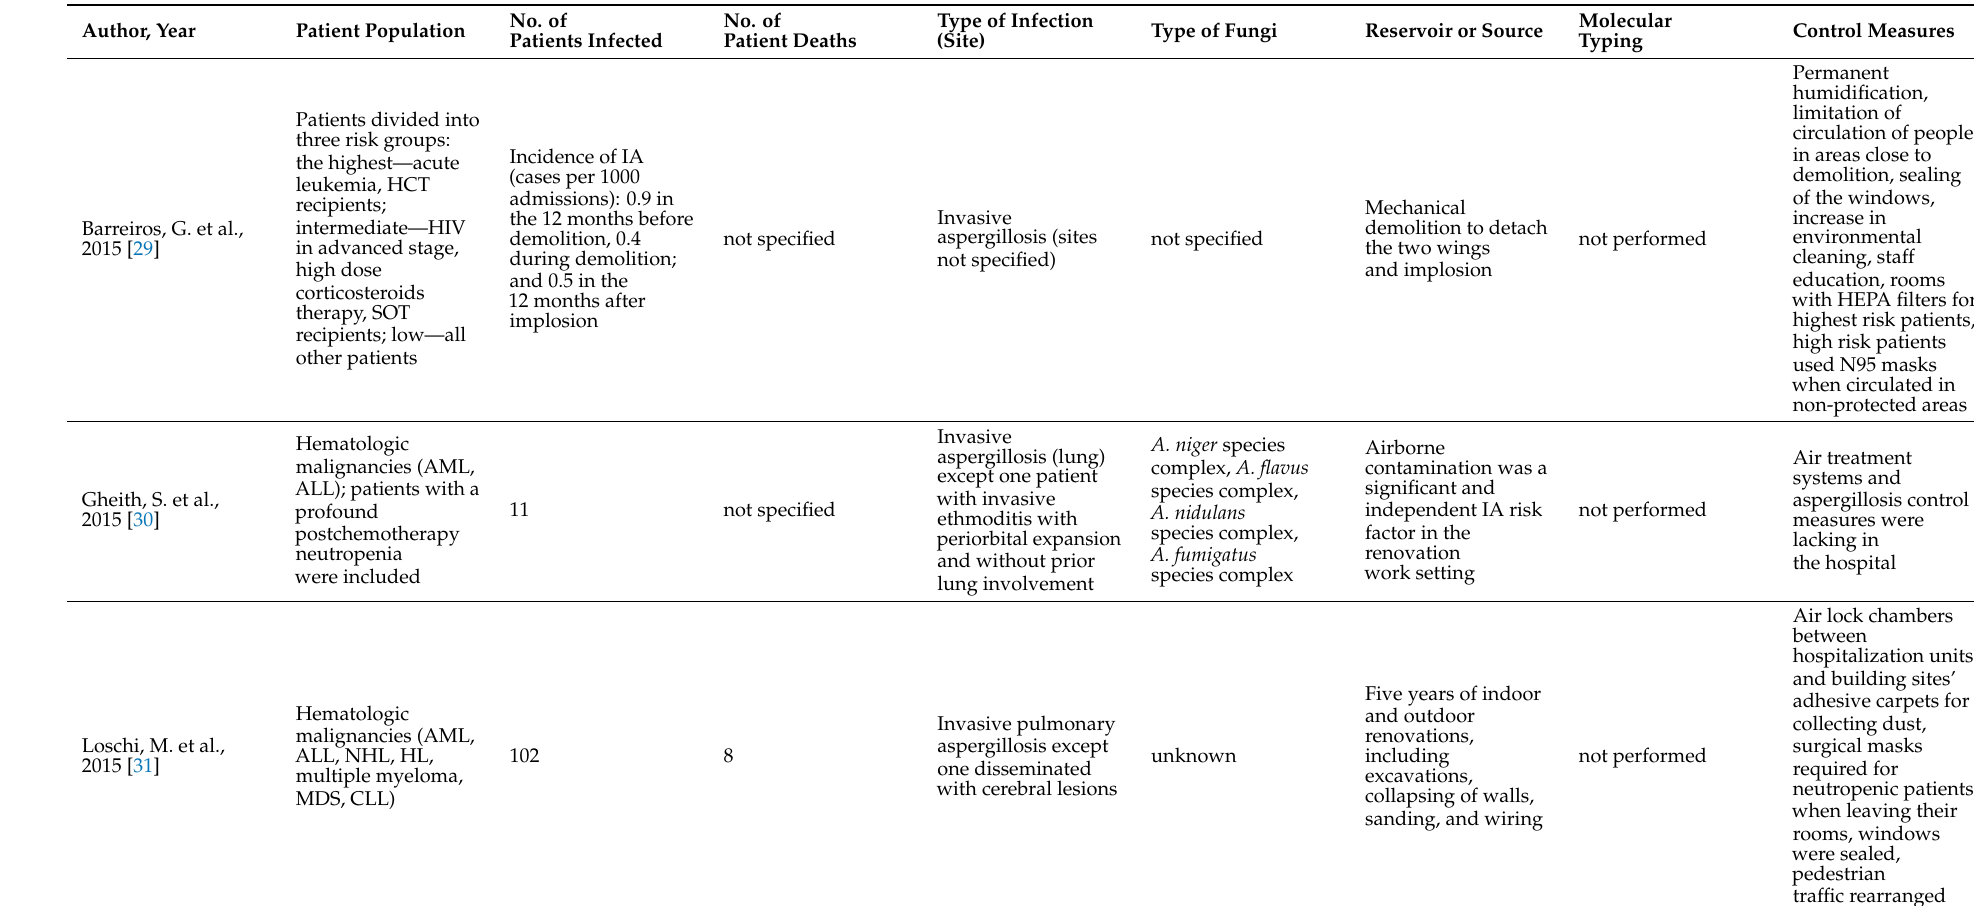
Table 1. Characteristics of fungal outbreaks and infections associated with construction or renovation described in articles published from January 2015 to December